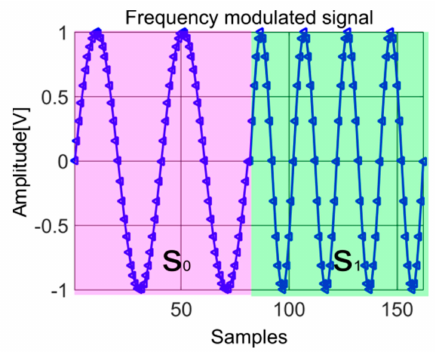
Figure 12. Signal with two successive frequencies, s, used for the illustration of the IF law estimation method.